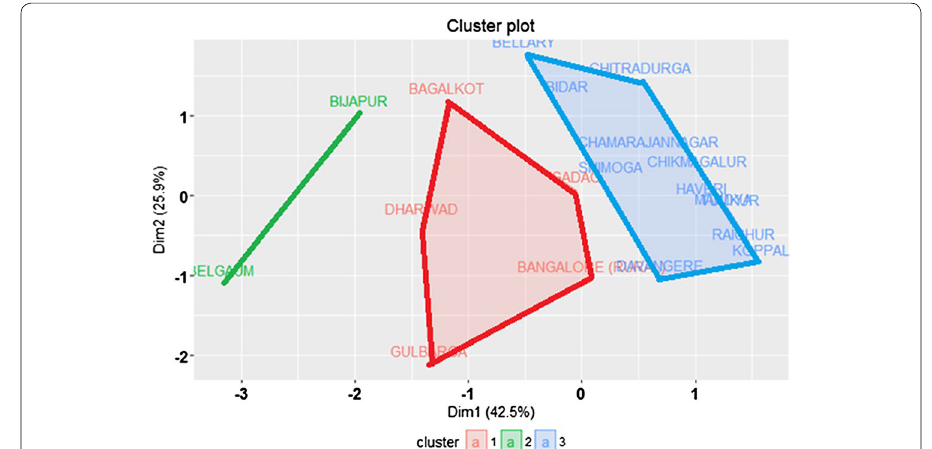
Fig. 11 Results of CLARA in R